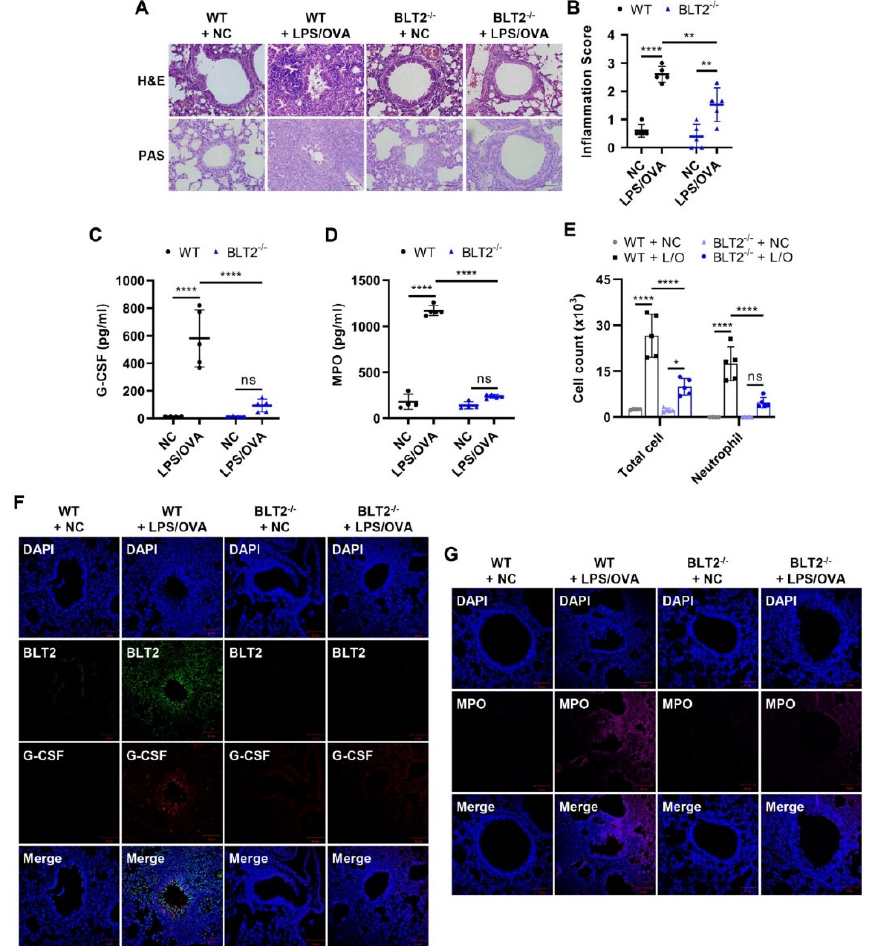
Figure 4. BLT2 knockout attenuates both G ‐ CSF production and neutrophilic airway inflammation. BLT2 − / − mice received the same schedule for sensitization and challenge (BLT2 − / − + LPS/OVA).